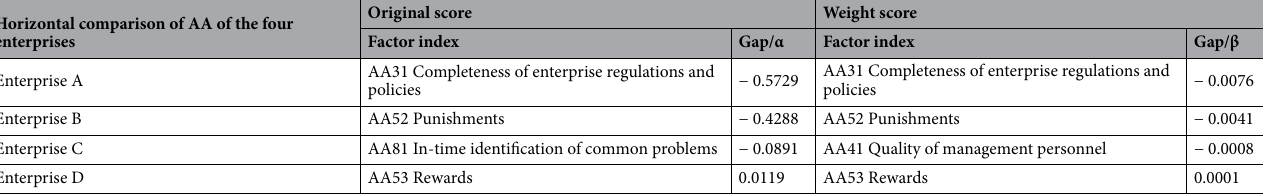
Table 14. Analysis of the shortcomings of the basic index scores of the safety management in four companies (AA of the first-level indexes)—horizontal